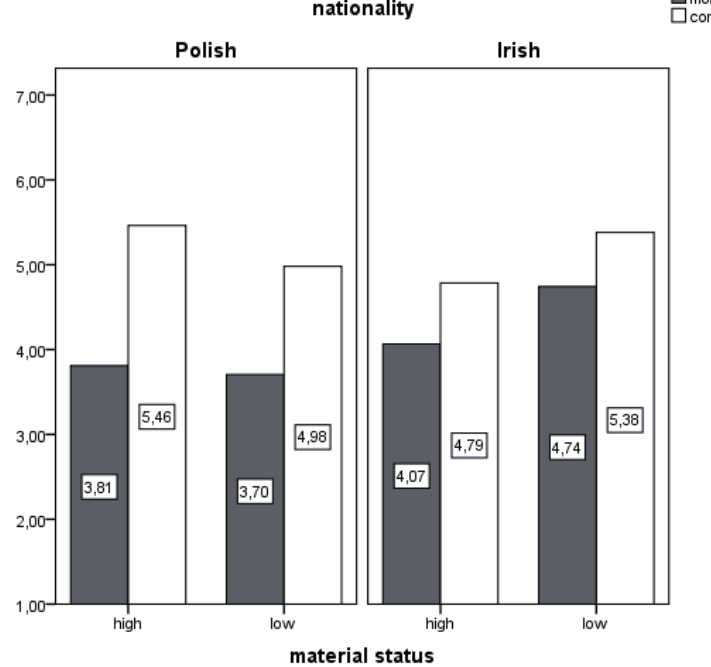
Figure 2. Mean scores for morality and competence assessments as a function of a politician`s material status and nationality of participants. Source: Own